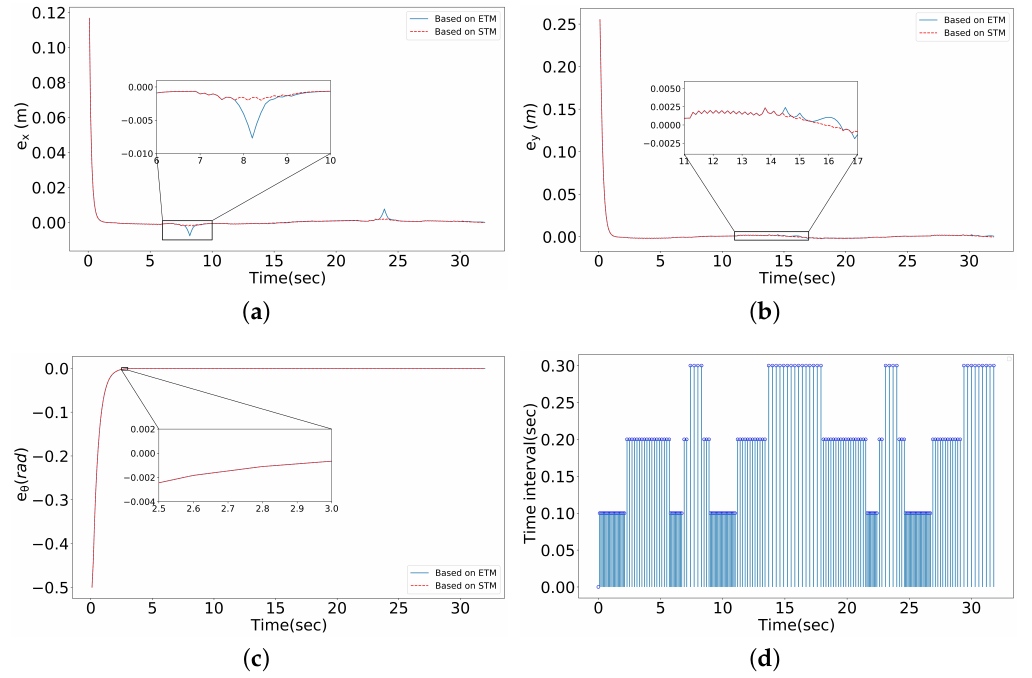
Figure 8. Simulation results with STM. ( a ) Pose error, e x . ( b ) Pose error, e y . ( c ) Pose error, e θ . ( d ) Triggering